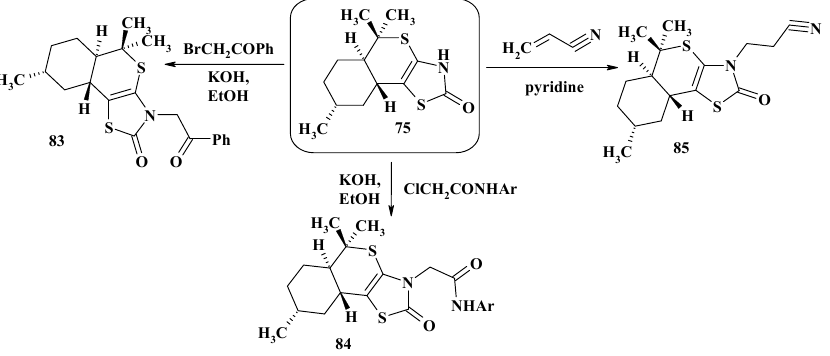
Scheme 27. Synthesis of 3-substituted chromeno[4 ′ ,3 ′ :4,5]thiopyrano[2,3- d ]thiazole-2-ones.